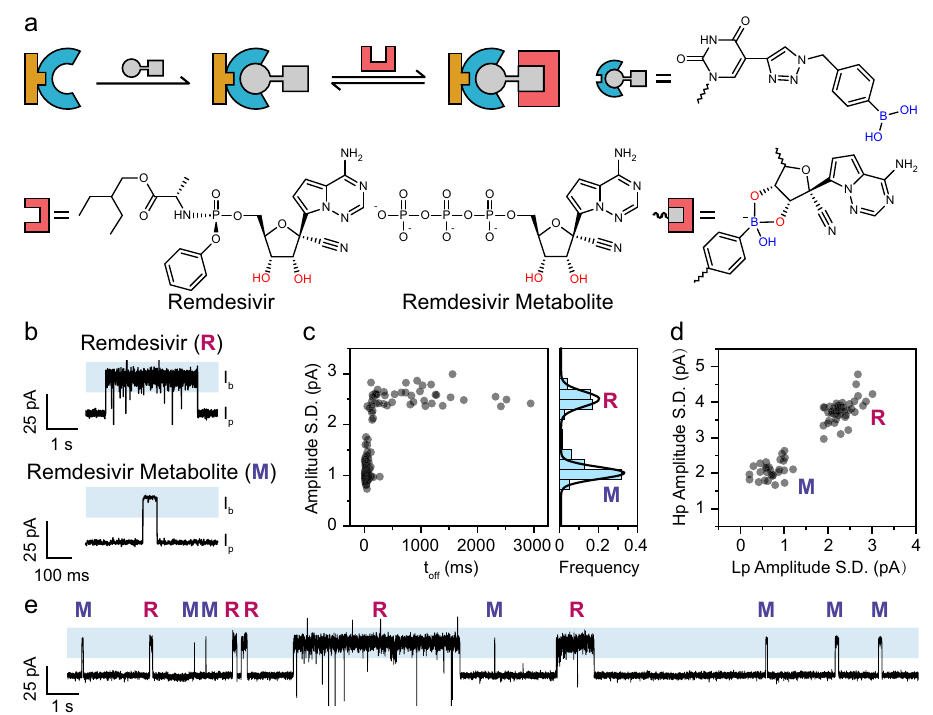
Fig. 6 PNRSS sensing of remdesivir and remdesivir triphosphate metabolite. a The sensing mechanism. Remdesivir and the remdesivir metabolite both contain a ribose moiety, capable of binding to a PBA. b Representative events of remdesivir and remdesivir metabolite. The label R and M respectively marks remdesivir and remdesivir metabolite. The events were Butterworth low-pass fi ltered with a cut-off frequency of 100 Hz (Supplementary Fig. 44). Both events appear positive going ( I b > I p ). Binding of remdesivir results in time extended events with characteristic noise fl uctuations. Remdesivir metabolite on the other hand reports transient events with minimum noise. c A scatter plot of event amplitude SD against the event dwell time. The histogram of the event amplitude SD and its Gaussian fi tting results were plotted to the right. Results of 119 events are included. d A scatter plot of high- pass (Hp) and low-pass (Lp) amplitude SD. Both analytes are clearly separated in the scatter plot. Results of 126 events are included. e A continuous trace containing binding events from remdesivir and remdesivir metabolite. The identity of each event is called based on event characteristics as described in d